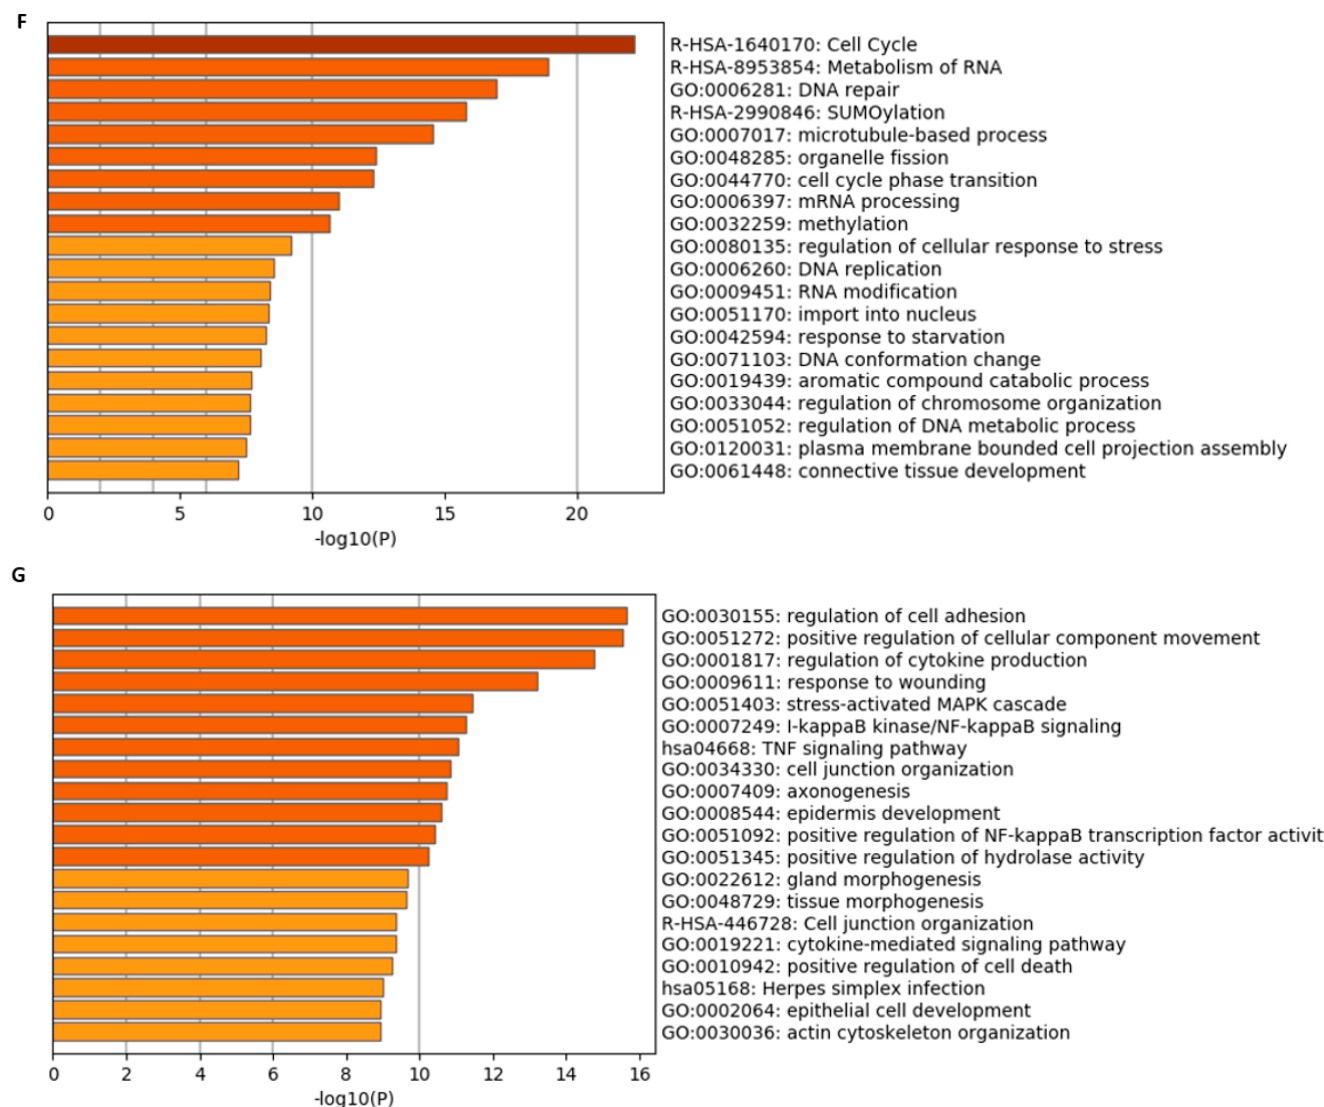
Figure 5. Comparative transcriptome and Gene Ontology analysis of untreated podocytes UM48 and UM51 and treated with angiotensin II for 6 h and 24 h. Podocytes were treated with ANGII (100 µ M) for 6 h and 24 h. The hierarchical cluster dendrogram revealed 2 distinct clusters—24 h treated and 6 h treated and untreated cells as a cluster. ( A ). Expressed genes (det- p < 0.05) in podocytes and after ANGII treatment are compared by Venn diagrams after 6 h ( B ) and 24 h ( C ), revealing unique and overlapping expression patterns. The most over-represented GO-BP terms (13922 genes) common in either condition are shown in ( D ) after 6 h of treatment and ( E ) after 24 h. The terms include locomotion, growth, immune system process, response to stimulus biological adhesion, metabolic process, and cell proliferation for the treated podocytes. The 10 most over-represented GO-BP terms in the upregulated (1287) and downregulated (1100) genes in podocytes treated for 24 h with ANGII in comparison with untreated cells are shown in ( F ). The upregulated genes are associated with cell cycle, DNA repair, cell cycle phase transition, methylation, and regulation of cellular response to stress, while downregulated genes are associated with regulation of cell adhesion, cell